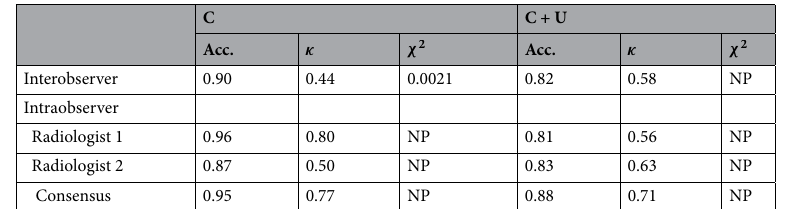
Table 4. Inter- and intraobserver variability of radiologist annotations considering as positives only CXRs marked as Indicative of COVID-19 (C) or Indicative of COVID-19 and Undetermined (C + U). χ obtained with the McNemar test (NP: power < 0.8